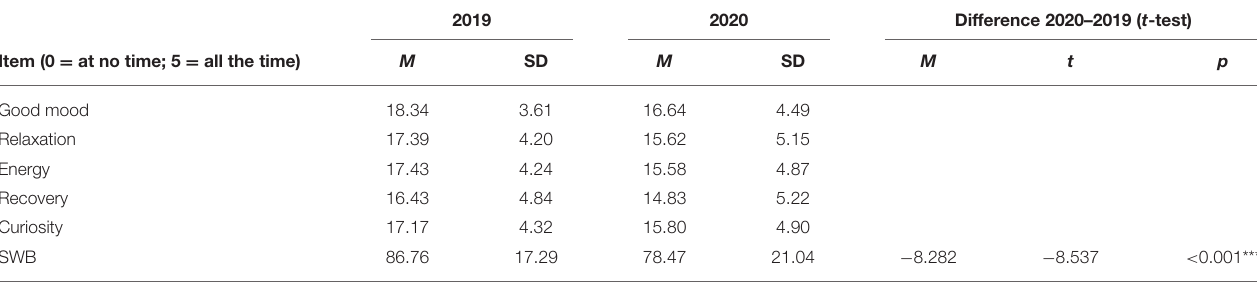
TABLE 2 | Well-being in 2019 and 2020 ( n = 412).